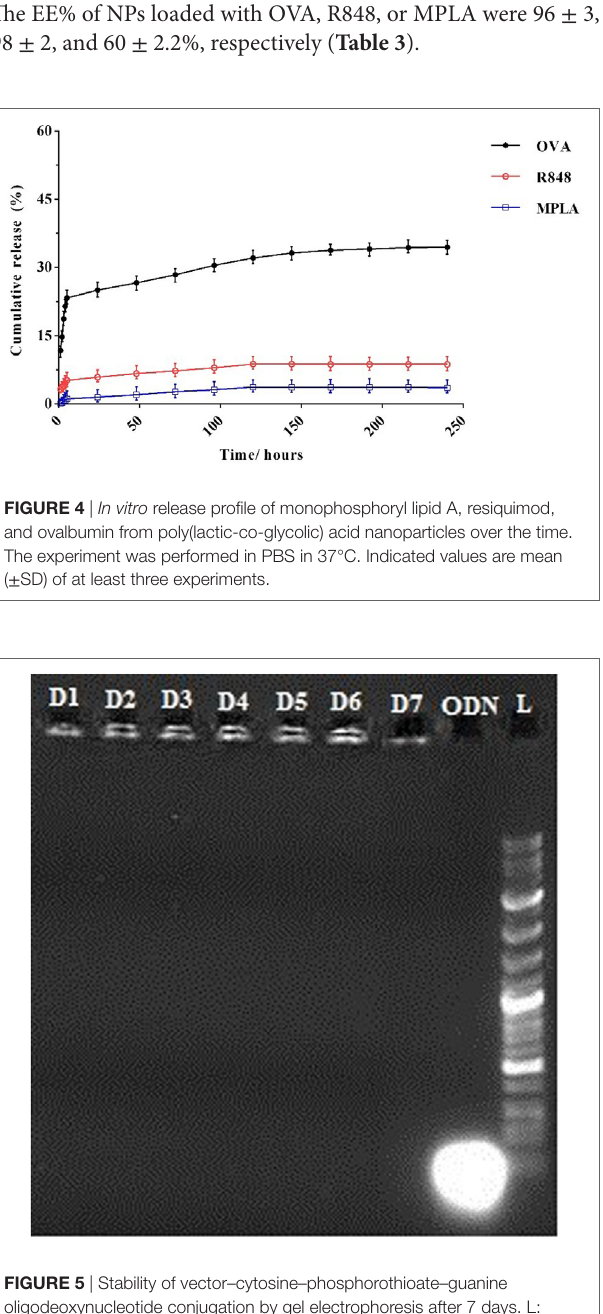
FigUre 5 | Stability of vector–cytosine–phosphorothioate–guanine oligodeoxynucleotide conjugation by gel electrophoresis after 7 days. L: Ladder 100k, ODN: CpG ODN, D1–7: Days 1–7.